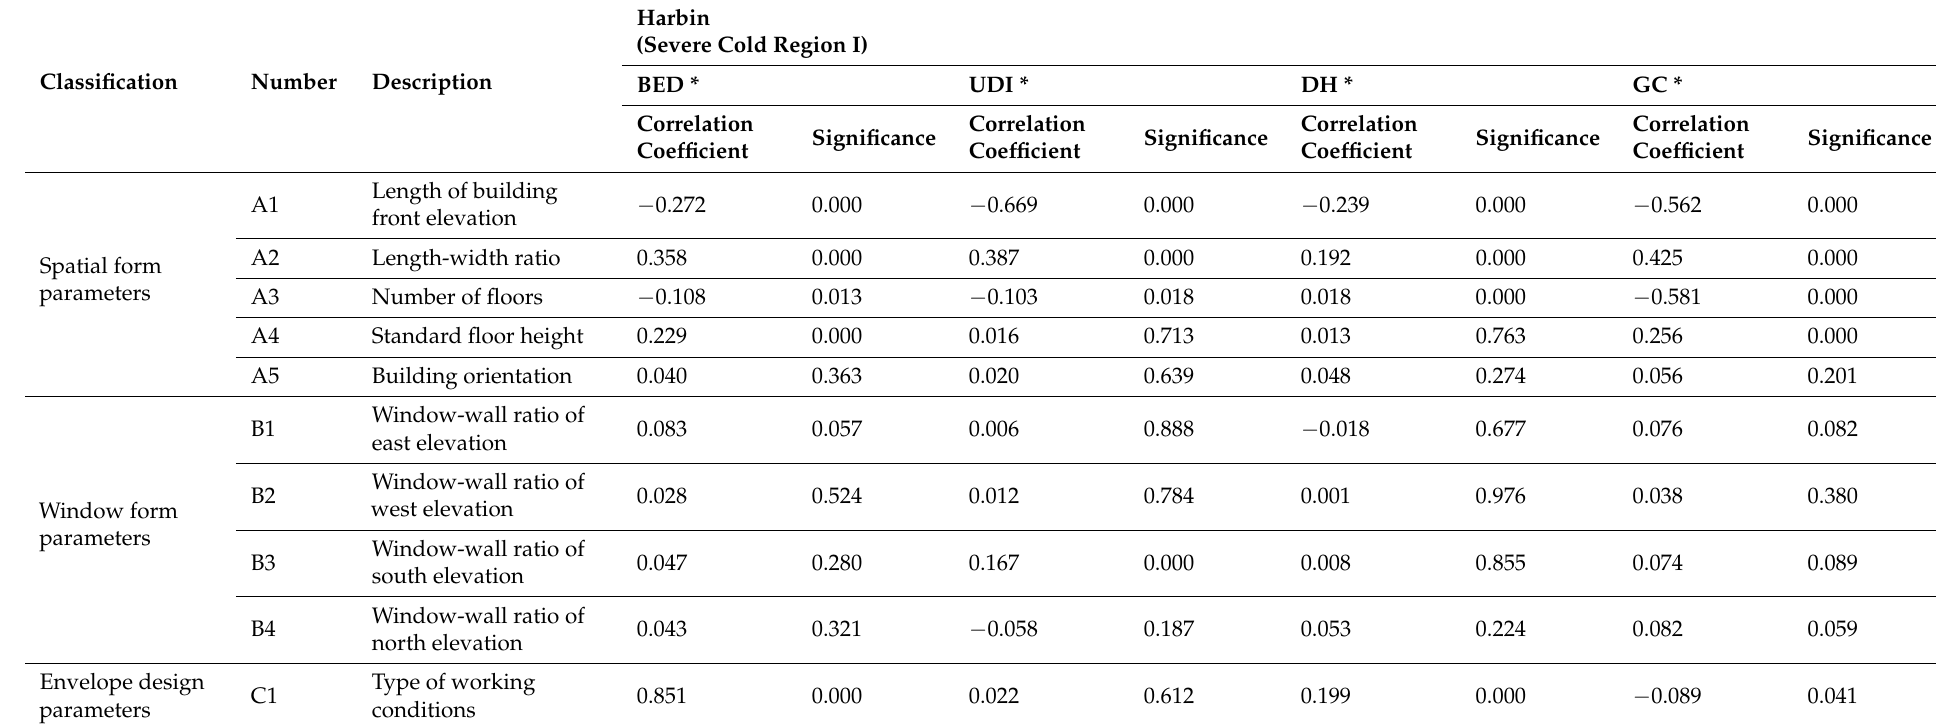
Table 8. Comparison of Spearman’s rank correlation coefficients of the design parameters of building forms in